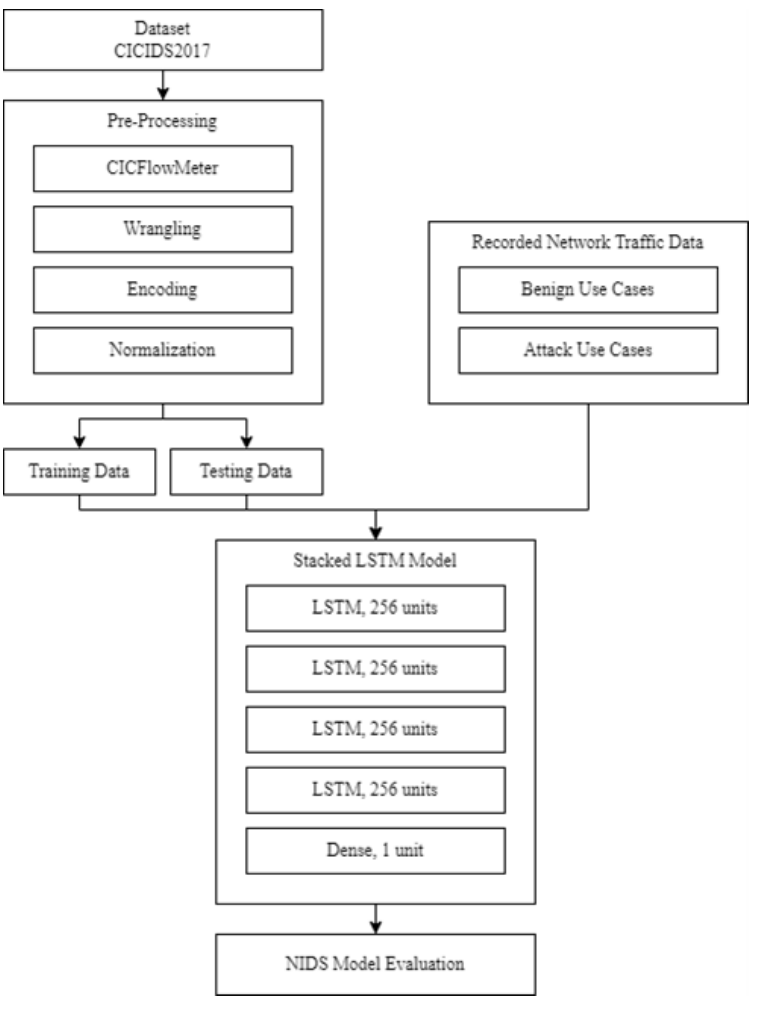
Figure 1. Anomaly-based DL NIDS